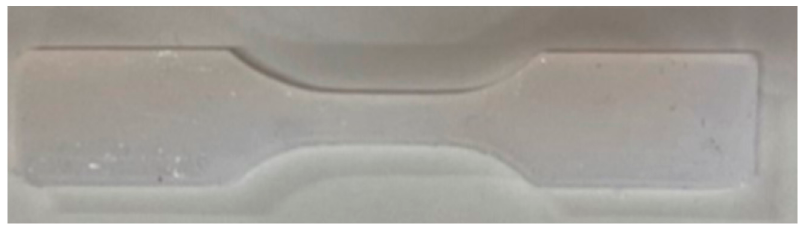
Figure 3. Tensile test specimens.